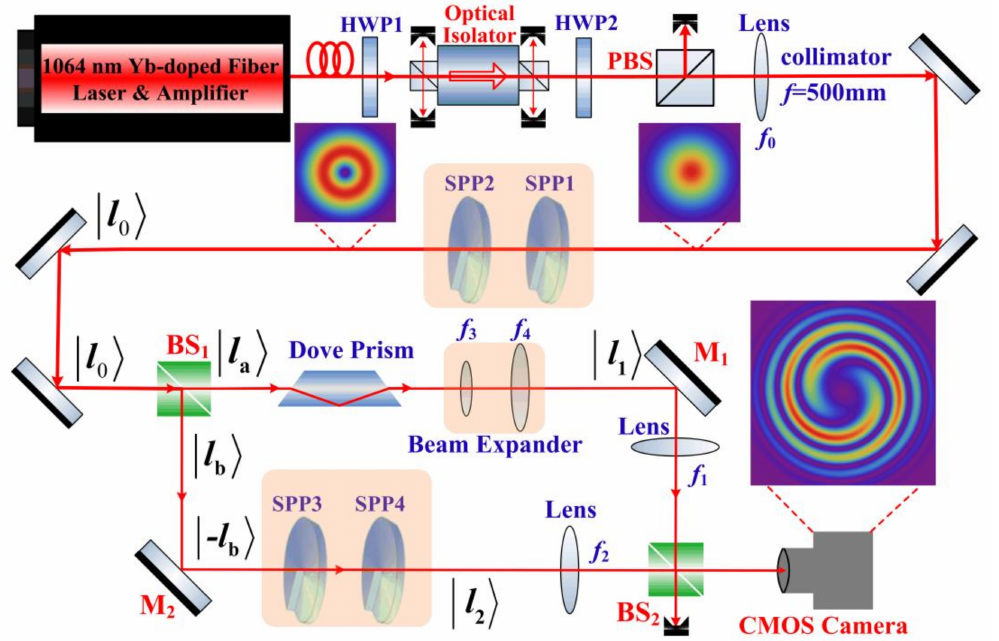
Figure 1. Schematic of the experimental setup; (inset); typical intensity distribution of the beams in the experiment. M 1 and M 2 , high reflection mirrors; f 0 – f 4 , lens; HWP: half-phase plate; PBS, polarizing beam splitter; BS, 50/50 non-polarizing beam